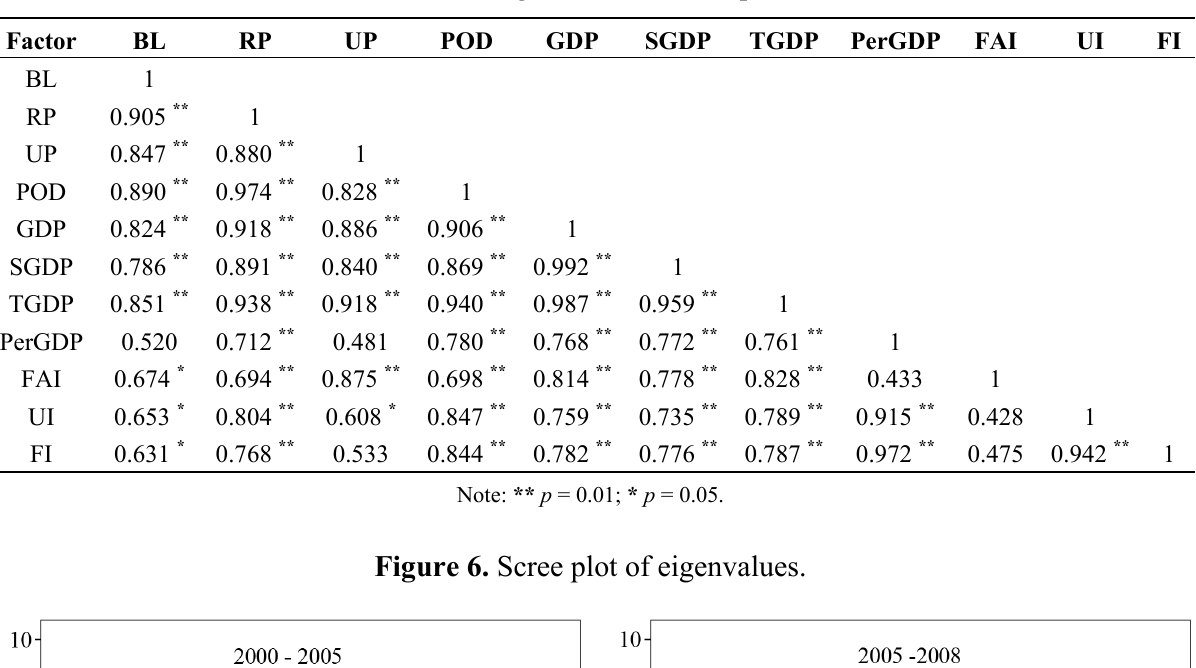
Table 6. Correlations among variables for the period of 2005–2008.